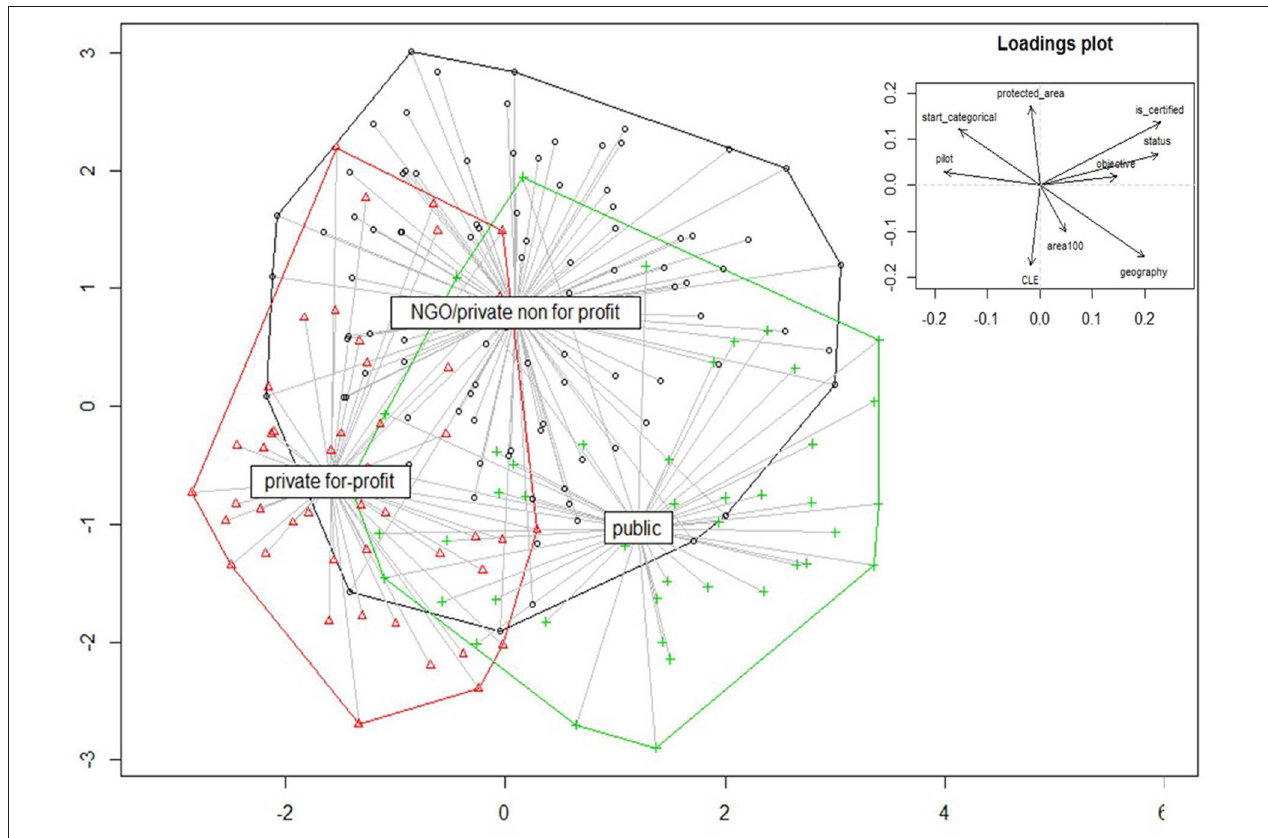
FIGURE 3 | Principal component analysis for REDD projects, excluding jurisdictional initiatives: multivariate homogeneity of group dispersions (variances) by implementer type. Data source: ID-RECCO database, 2018.